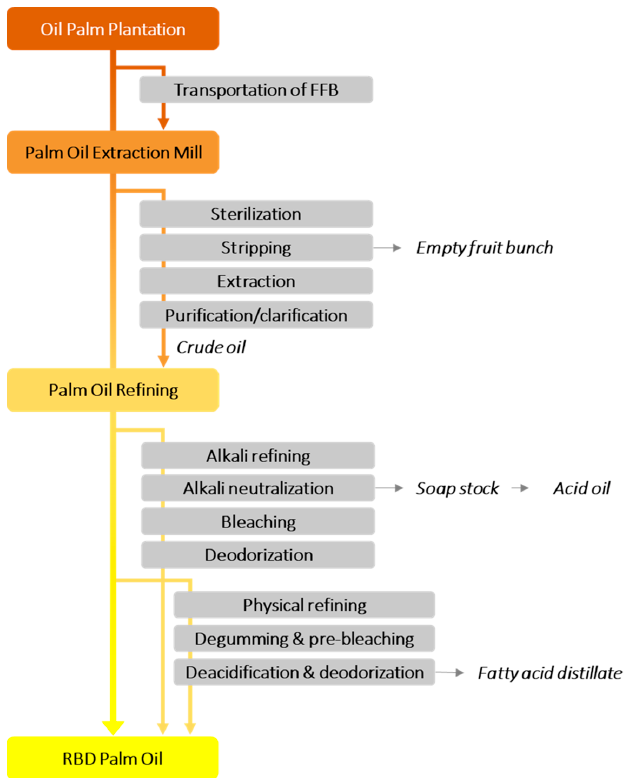
Figure 1. An example of full processing flow chart for a palm oil refining process from fresh fruit bunch (FFB) to the refined bleached deodorized (RBD) palm oil.